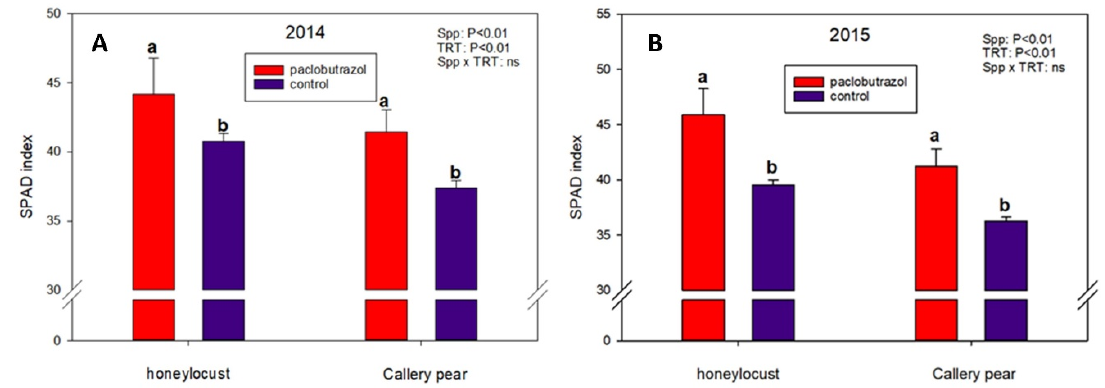
Figure 2. Mean SPAD chlorophyll index of honeylocust and Callery pear street trees in Lansing, MI, USA in 2014 ( A ) and 2015 ( B ). Trees were treated with paclobutrazol in 2013 or not treated (control). Error bars indicate standard error of the mean. Means within a species and year with the same letter are not different at p = 0.05.